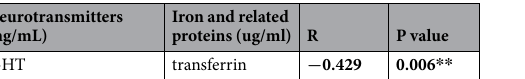
Table 3. Correlation between the levels of 5-HT and transferrin in CSF in PD with fatigue group. 5- HT = serotonin; ** P < 0.01.